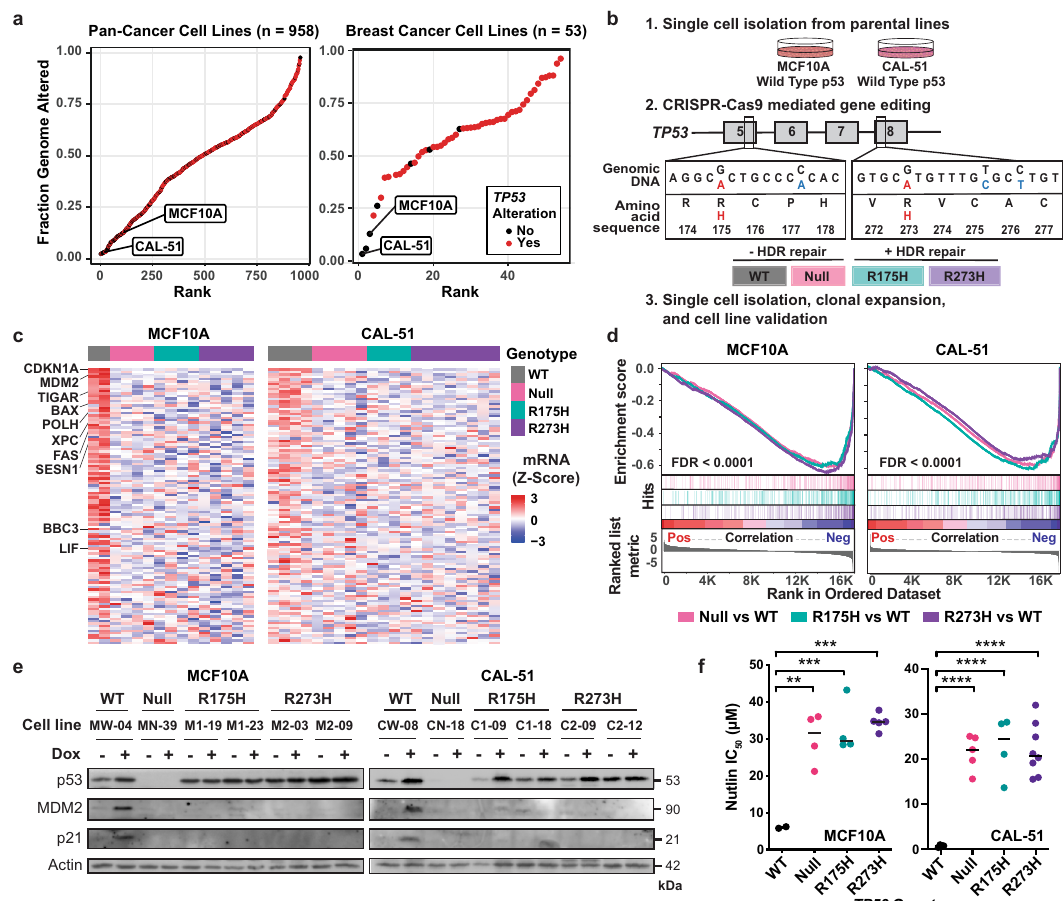
Fig. 1 Generation and characterization of genetically engineered epithelial cell line models to study potential mutant p53 GOF activities. a Fraction of the genome altered across pan-cancer ( n = 958, left panel) and breast cancer cell lines ( n = 53, right panel) from the Cancer Cell Line Encyclopedia, with (red) and without (black) TP53 alterations (mutation or deletion); including the nontransformed MCF10A cell line. b Experimental work fl ow for CRISPR- Cas9 genetic engineering of isogenic cell line models with TP53 missense (red) and synonymous (blue) mutations and the resulting isogenic cell lines that either did (R175H and R273H, + HDR) or did not undergo complete homology-directed repair (WT and Null, − HDR). HDR homology-directed repair. c Heatmap of normalized gene expression for the top 116 p53 target genes 33 for all cell lines at passage fi ve after clonal expansion. d GSEA plot showing negative enrichment of p53 target genes (Fischer Direct p53 Targets Meta Analysis geneset) from RNA-seq differential gene expression analyses between TP53 Null (pink), R175H (teal), and R273H (purple) clones compared to the MCF10A and CAL-51 WT cell lines. Pos positive, Neg negative, FDR false discovery rate. e Western blots of relative p53, MDM2, p21, and actin protein levels in the indicated cell lines after 6 h of doxorubicin treatment (dox, 0.2 µ M). Western blots of additional cell lines are shown in Supplementary Fig. 1b, c. Blots are representative of two independent experiments. f IC 50 values for Nutlin-3a in the MCF10A ( n = 2 WT, 4 Null, 4 R175H, and 5 R273H) and CAL-51 ( n = 4 WT, 5 Null, 4 R175H, and 8 R273H) cell lines after treatment for 72 h. Dots represent the mean IC 50 per cell line calculated from at least two independent experiments and black lines indicate median IC 50 per TP53 genotype. One-way ANOVA with Dunnett ’ s multiple comparison test, ** P < 0.01, *** P < 0.001, **** P < 0.0001. Source data and exact P values are provided in the Source Data p53 mutant isogenic cell lines display increased frequency of